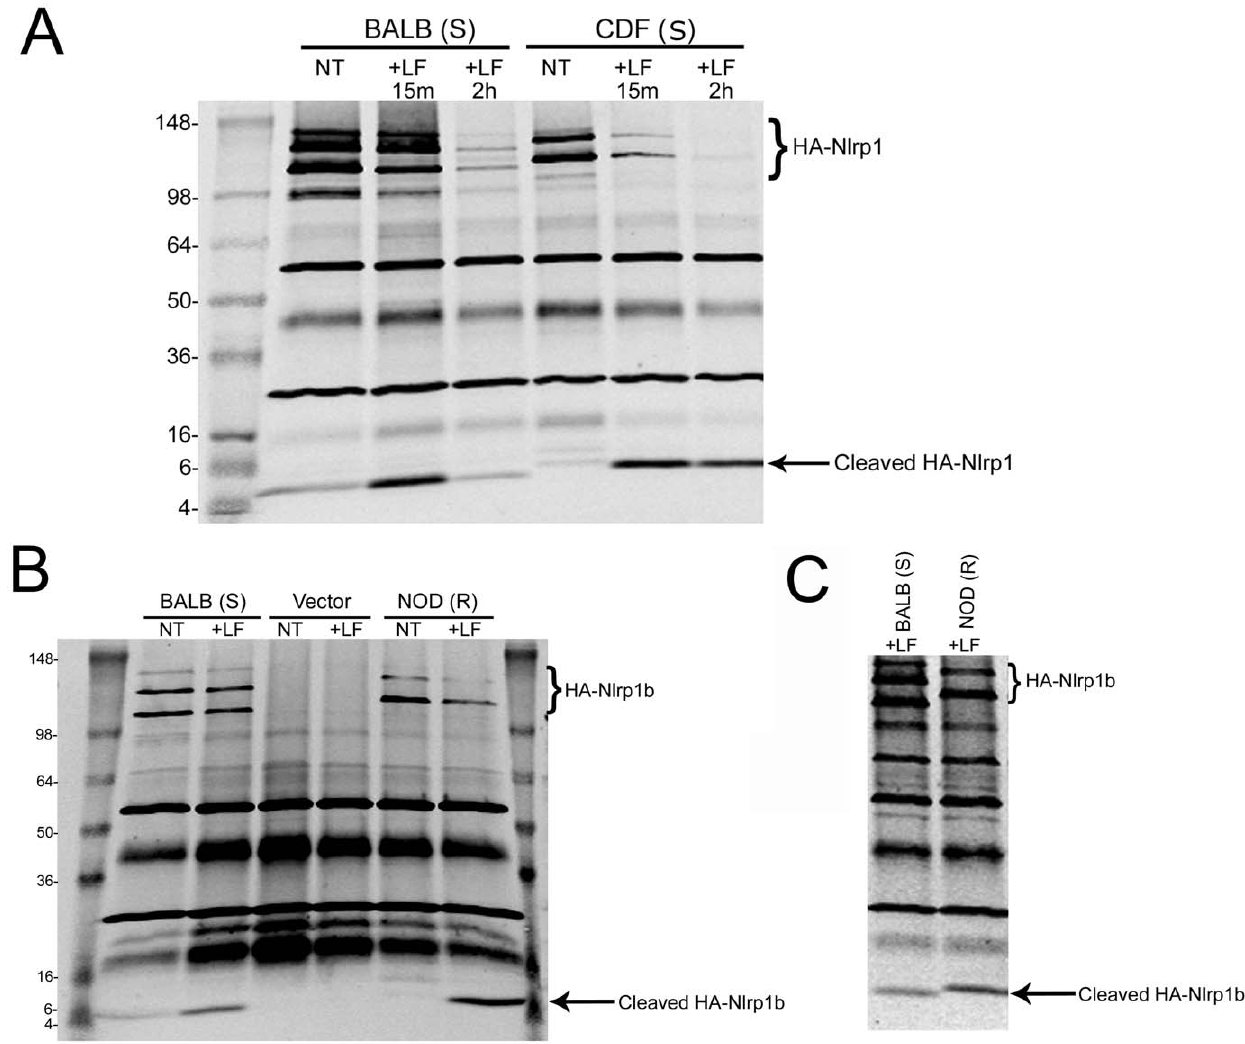
Figure 2. Cleavage of full length rat and mouse Nlrp1b proteins by LF. (A) IP (anti-HA pulldown) followed by anti-HA Western blotting of lysates from HT1080 cells expressing HA-tagged mouse Nlrp1b (BALB) or rat Nlrp1(CDF) proteins following treatment with LF (1 m g/ml) for 15 min or 2 h. Cleavage of CDF Nlrp1 leads to appearance of a 6-kDa HA-reactive band and cleavage of BALB Nlrp1b leads to a slightly smaller fragment. (B) IP (anti-HA pulldown) followed by anti-HA Western blotting of lysates from HT1080 cells expressing HA-tagged Nlrp1b proteins or control vector following treatment with LF (1 m g/ml, 30 min). Anti-HA cross-reactive bands not marked as HA-Nlrp1 also appear in vector-transfected controls. (C) Comparison of size of cleavage fragments generated after cleavage of BALB and NOD HA-tagged Nlrp1b (using conditions same as 2B), indicating the smaller size of the fragment generated following cleavage of the BALB protein (Western representative of five similar experiments).